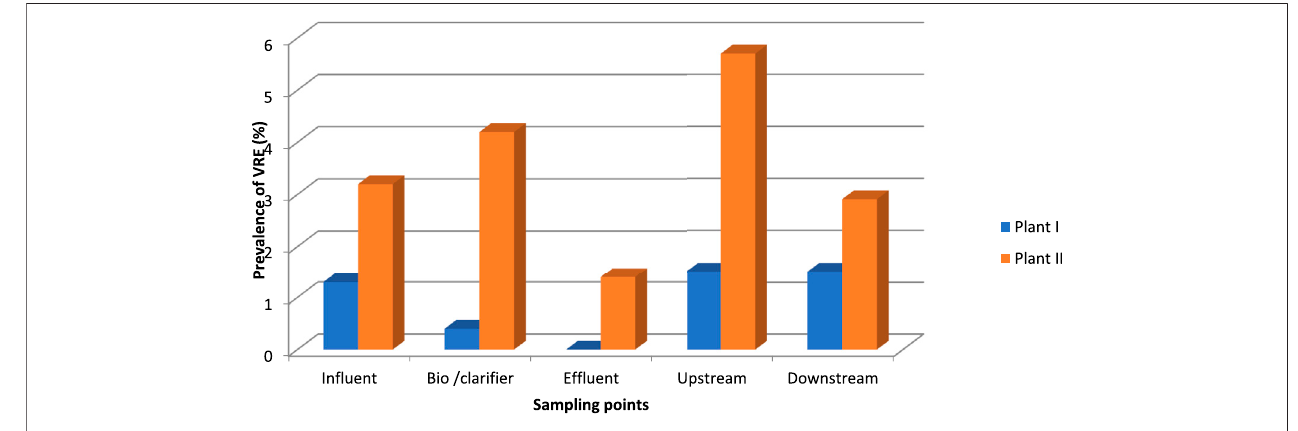
FIGURE 1 | Comparison of the prevalence of VRE between Plants I and II.